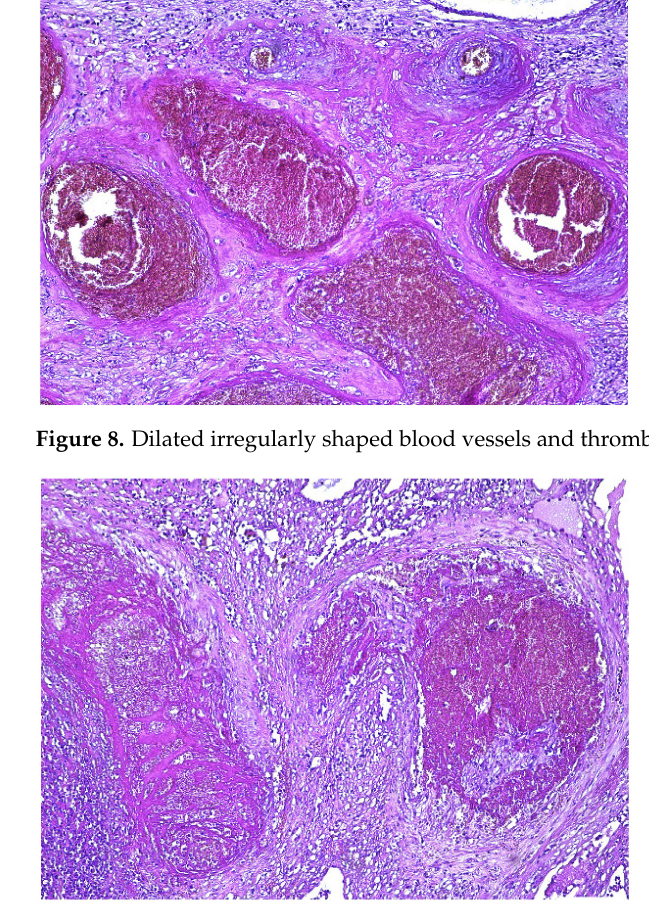
Figure 9. Vascular malformation and thrombi (HE ×